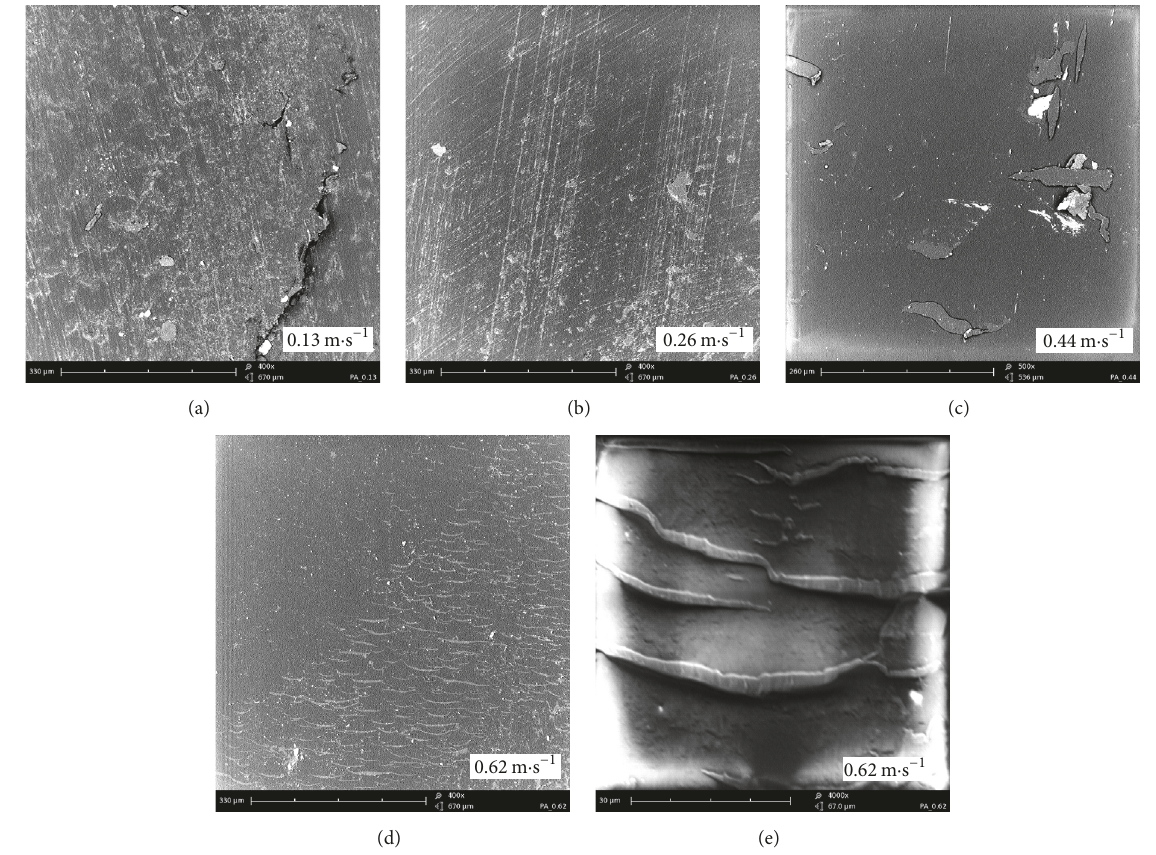
Figure 11: Effect of sliding velocity on worn surfaces of PA 6.6 tested at various sliding velocities: ((a) and (b)) cracks, small parallel scratches, and wear products pressed in the specimen surface, (c) sparse overlaps of the material, (d) zone with scaly structure, formed of “roll-shaped particles,” and (e) magnified “roll-shaped particles,”